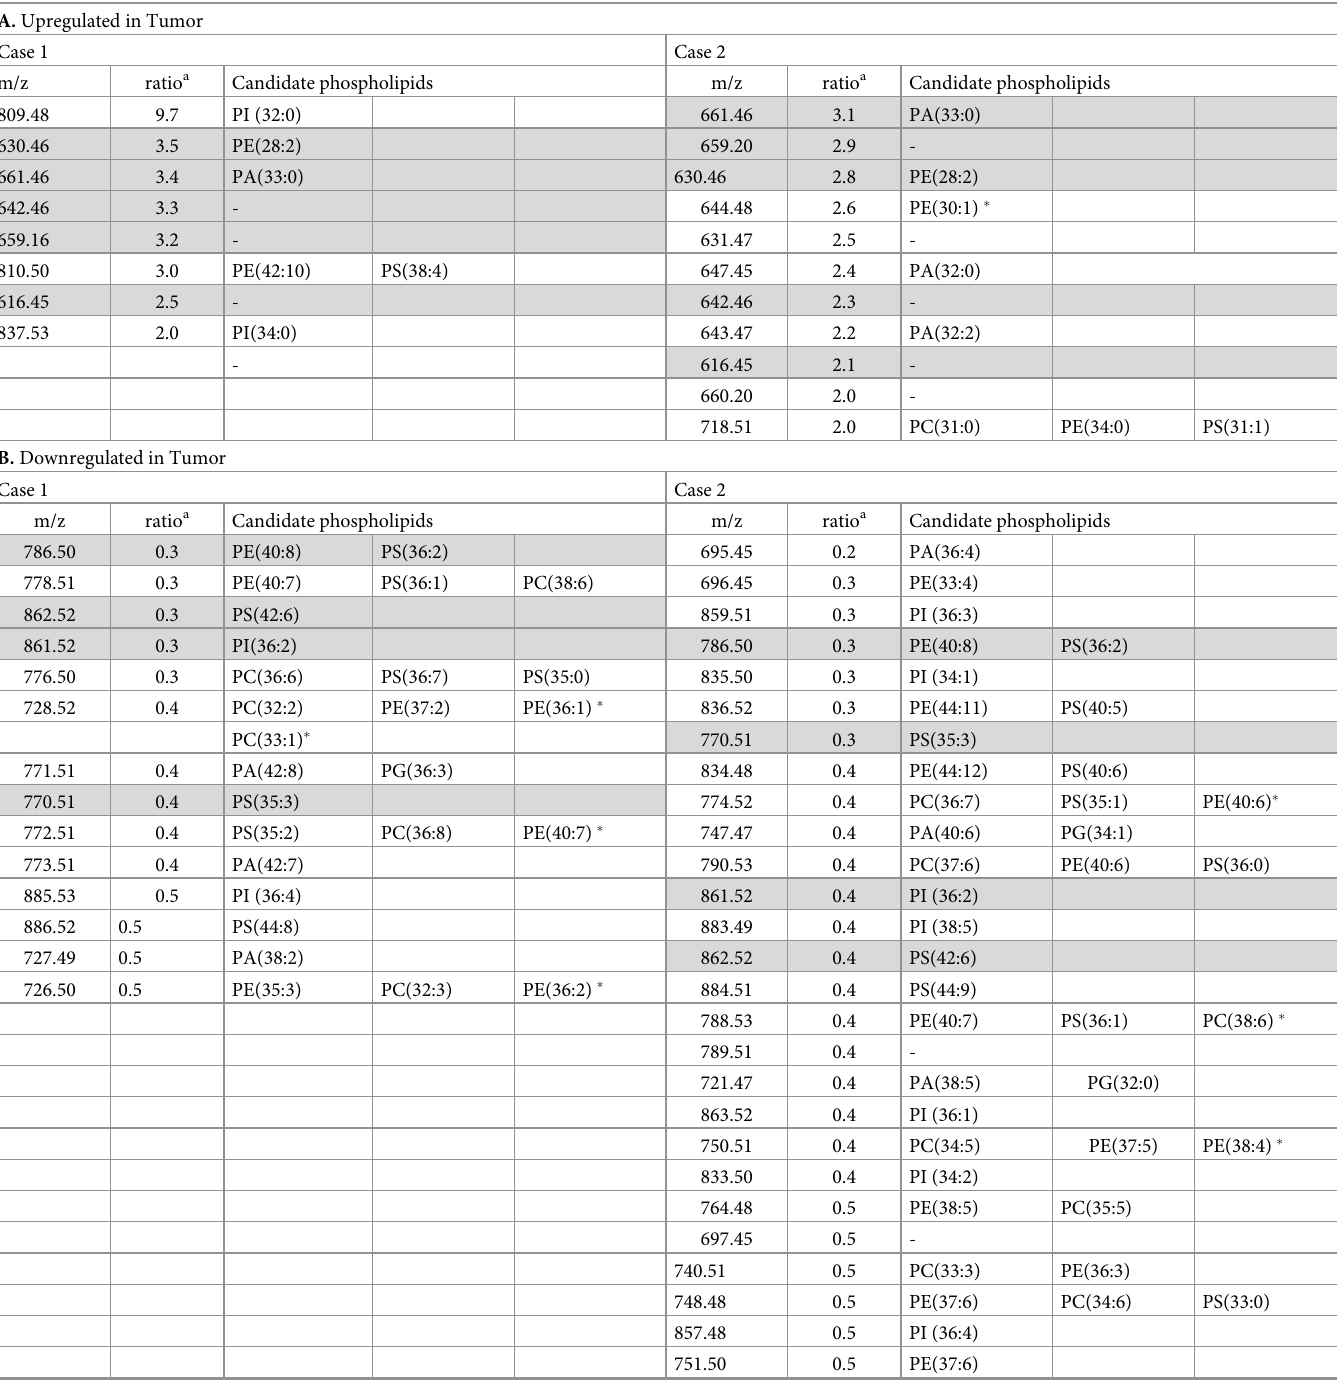
Table 2. Altered peaks identified by MALDI-IMS and corresponding candidate phospholipids in negative ion